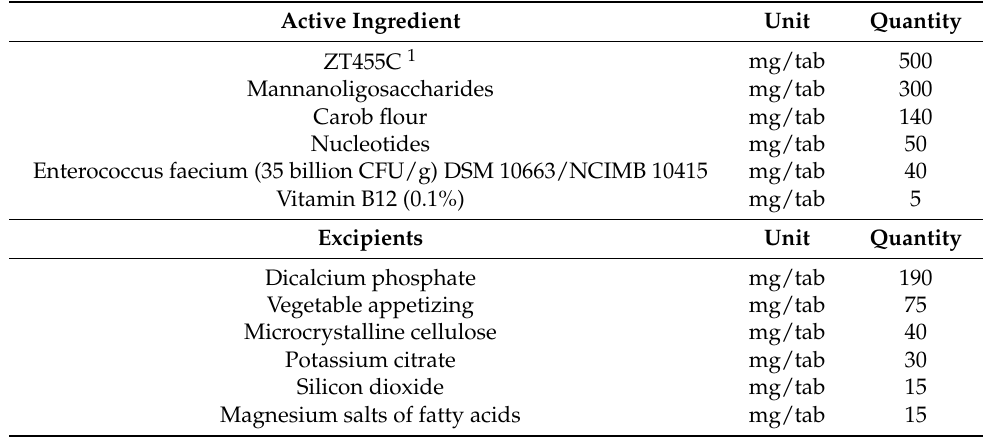
Table 1. Composition of nutraceutical complimentary feed (tablets 1400 mg).